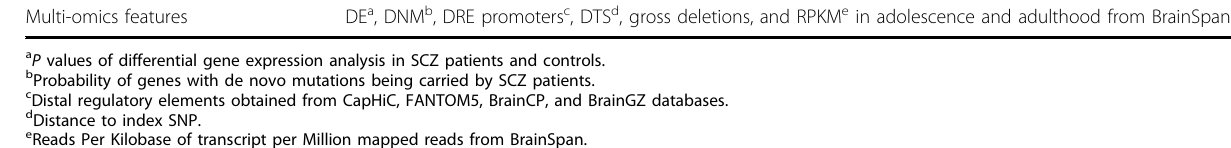
AutDBCCSECGEGFMRP.AscanoFMRP.DarnellFUMAGABAHGMHRARmiR.137.targetsPRAZPRPPSDSYV